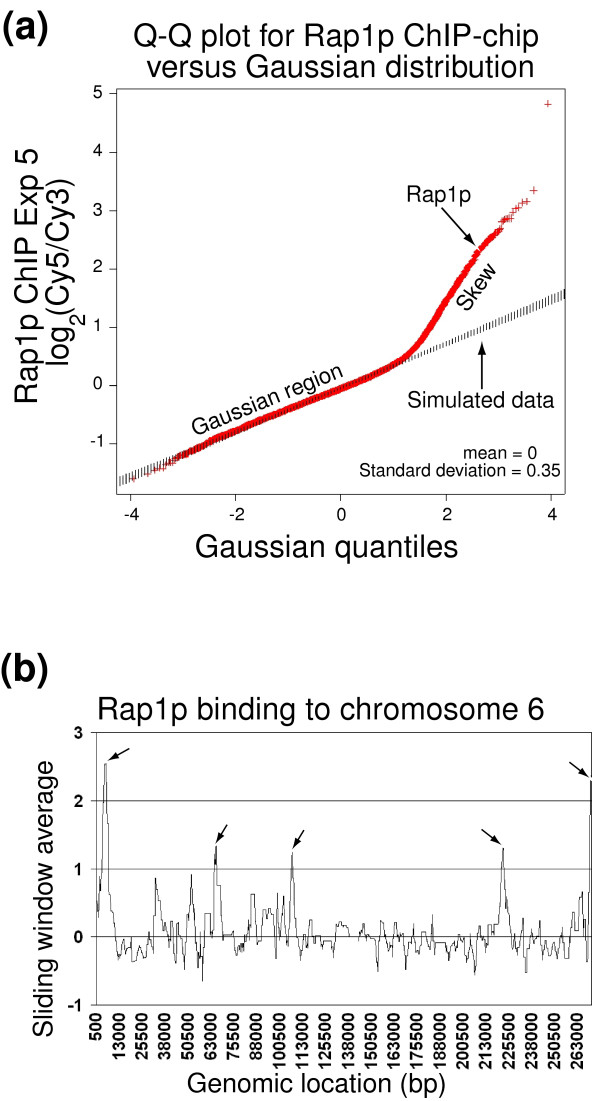
Characteristics of ChIP-chip data. (a) A quantile-quantile plot (QQ plot) for one representative Rap1p ChIP-chip experiment (red) against Gaussian distribution with a standard deviation of 0.35 and a mean of 0 (black bars). The upper and lower bounds of the black dashed line represent extreme values for 10,000 simulated Gaussian distributions with the above parameters. For Rap1 about 92% of the data fit the Gaussian distribution. The top 8% is skewed away from the simulated data. (b) A sliding window analysis for yeast chromosome VI produced by ChIPOTle for four Rap1p replicates [13]. Window size is 1 kilobase (kb) with 0.25 kb step size. The Rap1p binding sites are identified with arrows.